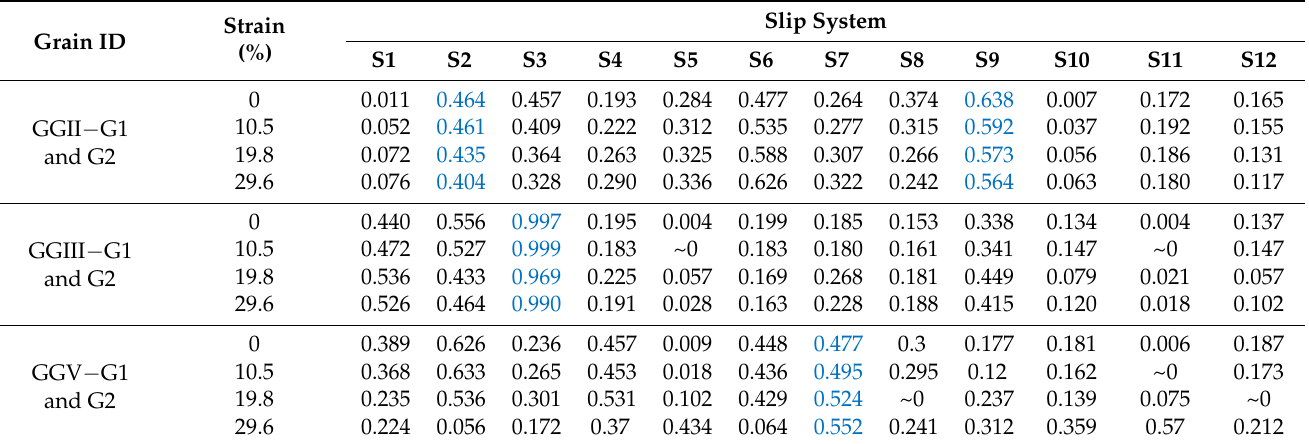
Table 3. The variation of m (cid:48) values of several grains during tensile